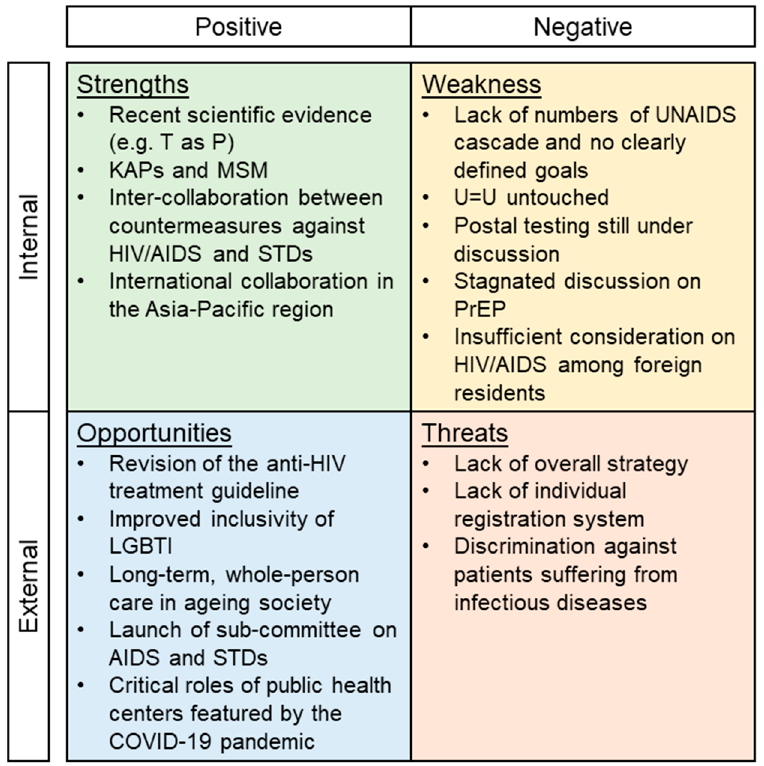
Figure 1. SWOT analysis of the Guidelines on Prevention of HIV/AIDS in Japan.